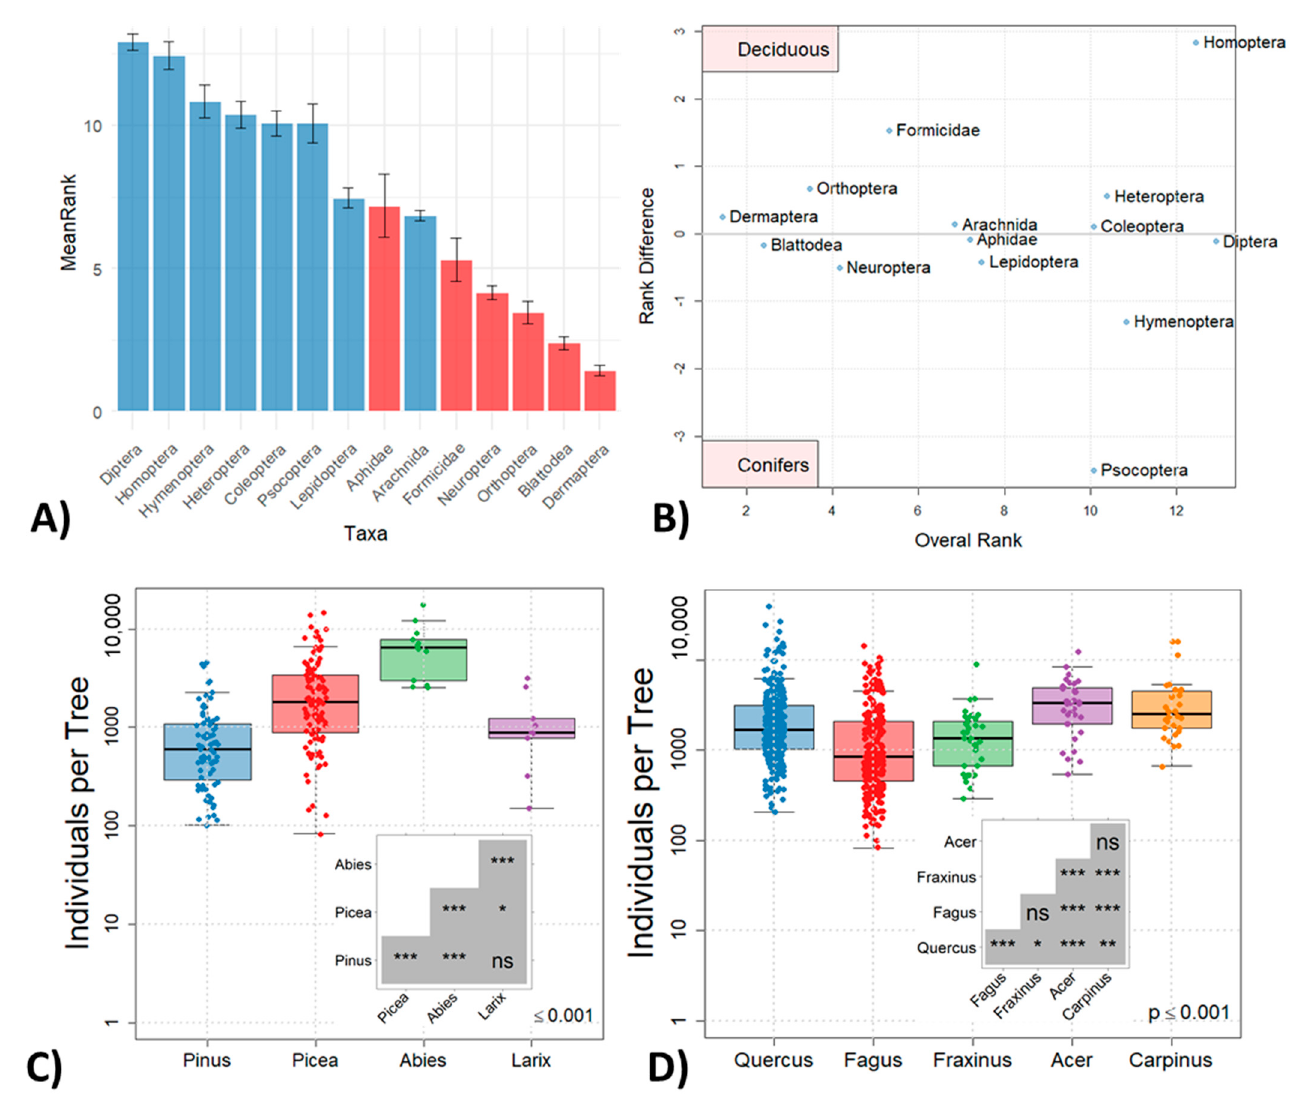
Figure 3. ( A ) Arthropod taxa were arranged in a distinct rankorder on the trees, as visualised by mean ranks with standard errors (+/ − 1 standard error of the mean), with the highest rank equal to 14. “Major taxa” are in blue; “minor taxa” are in red (see text) ( B ). Plotting the rank differences of taxa on deciduous and coniferous trees emphasises taxa preferences. The further to the right a taxon is on the x -axis, the more often it was found in a high rank; the further up or down on the y -axis, the more taxa were preferentially collected from deciduous or coniferous trees. Figures ( C , D ) show the overall distribution of arthropods on conifers and deciduous trees; both indicate overall differences within deciduous trees and conifers (Kruskal Test, p < 0.001). The difference in the means of all tree genera was compared, and the associated adjusted significance levels are displayed in the inlays (Wilcoxon test with multiple testing correction), p < 0.05 (*), p < 0.01 (**), p < 0.001 (***).